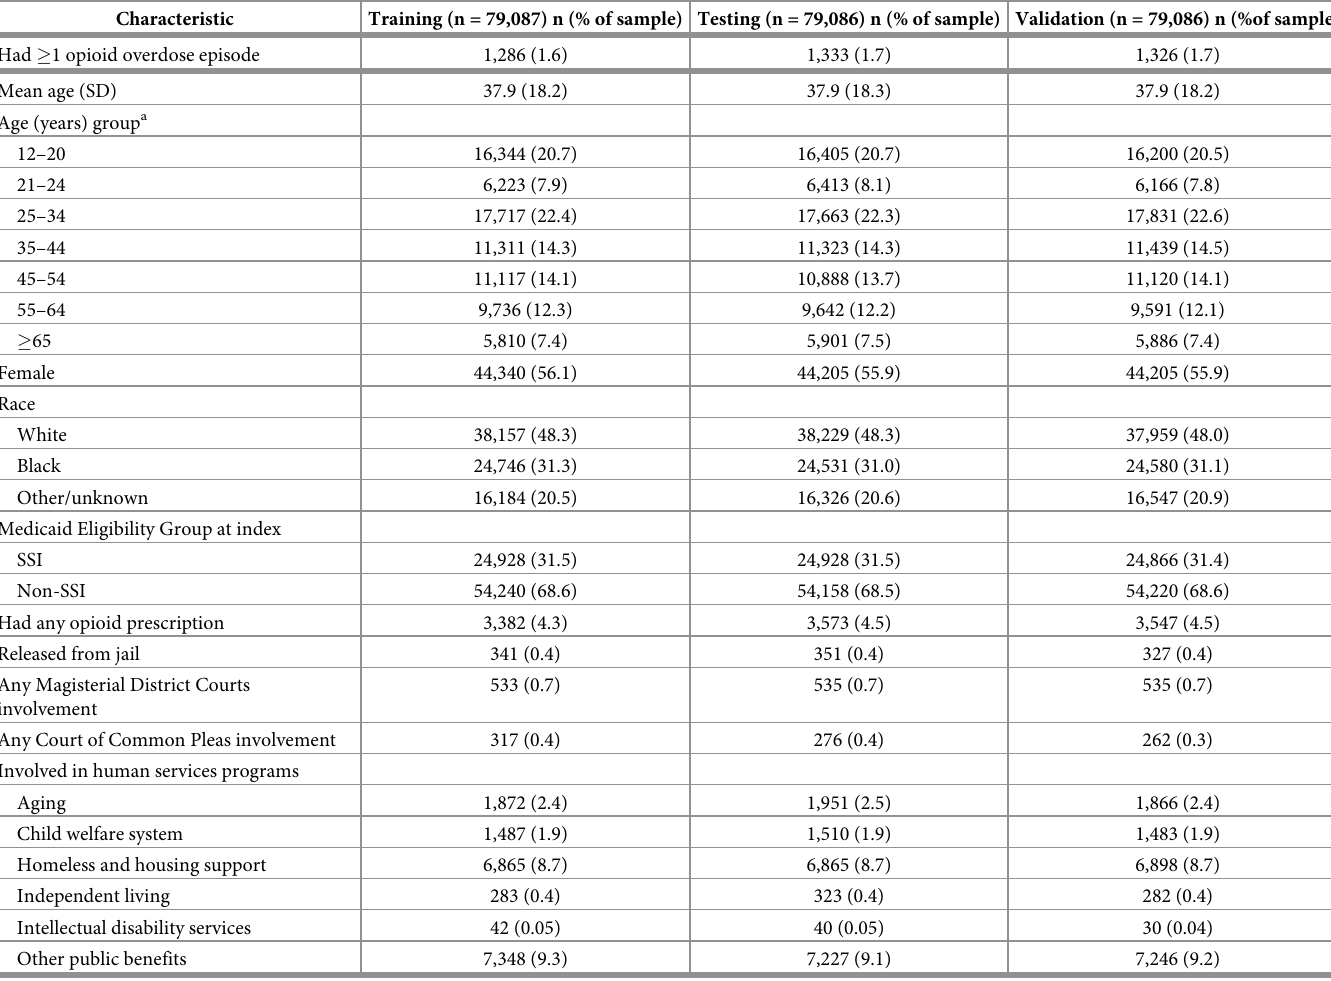
Table 1. Characteristics of Medicaid beneficiaries (n = 237,259) in Allegheny County, Pennsylvania USA, divided into training, testing, and validation samples.